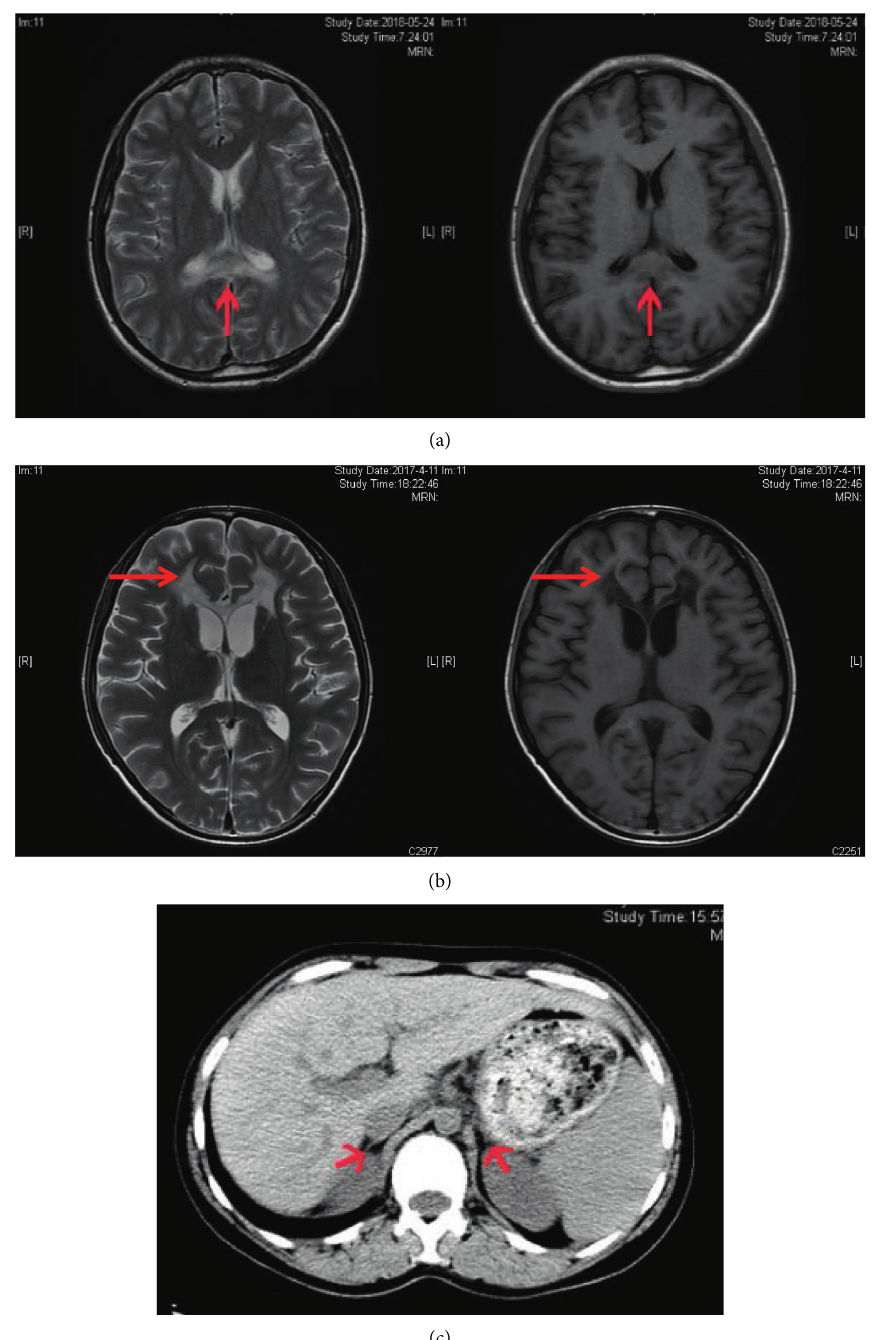
Figure 1: Brain magnetic resonance imaging (MRI) scan of patients. (a) Symmetric bands with high T2 low T1 abnormal signal in bilateral genu of the corpus callosum detected in case one. (b) MRI scan of case two revealed long T1 and long T2 signals in white matter of bilateral frontal lobes, around the anterior of lateral ventricle, and splenium of the corpus callosum. (c) Computed tomography (CT) scan of the adrenal gland of case one to show bilateral adrenal atrophy. Red arrow shows